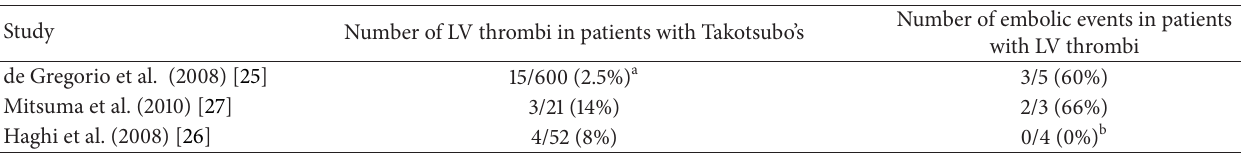
Number of embolic events in patients with LV thrombi